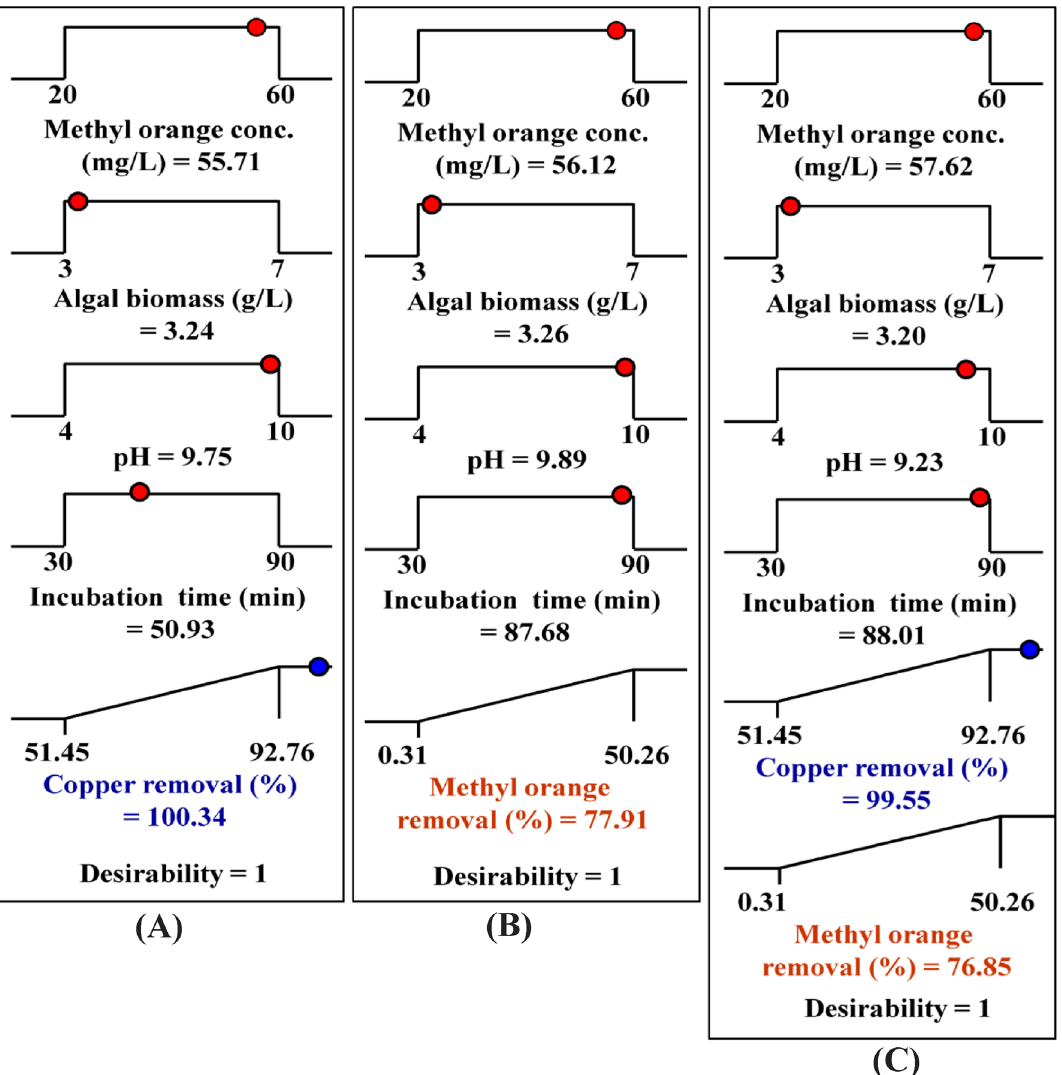
Figure 3. The optimization plot displays the optimum predicted values and the desirability function for maximum simultaneous removal percentages of anionic methyl orange azo dye as mono-component (A) ; cationic copper ions as mono-component (B) ; both copper ions and methyl orange in binary multi-component system (C) . This figure was created by using Design Expert version 7 for Windows FTIR analysis. The FTIR spectrums of brown alga F. vesiculosus biomass were analyzed before and after bio-adsorption of methyl orange and copper (Fig. 4) showing differences due to the interaction of methyl orange and copper ions with active sites (functional groups) that found in cell surface in biomass. The brown algae cell walls consist of cellulose, hemicelluloses, sulphated furans and also some unique polysaccharides (alginates) that have many active groups (hydroxyl, carboxylate, amino and phosphate groups) with negative charges that can interact with cationic dye and connect the ions of heavy metal 59 . The spectrum of FTIR analysis of brown alga F. vesiculosus before and after bio-sorption of MO and copper ions showed different absorption peaks at 3751, 3450, 2924, 2855, 1743, 1649, 1563, 1544, 1520, 1461, 1425,1397, 1342,1318, 1161,1063 and 672 cm −1 which has been shifted to 3450, 2962, 2925, 2855, 1742, 1647, 1564, 1545, 1520, 1461, 1426, 1399, 1342, 1270, 1160, 1066, 672 and 615 cm −1 . Figure 4 represent that very narrow peak at 3751 are present in the brown alga F. vesiculosus and no present after absorption MO and copper ions. Some other peaks are shifted in range 3 to –22 cm −1 due to the brown alga adsorbed copper ions and methyl orange. Also, the new peaks were observed at 1270 and 615 cm −1 this change may be due to bind of MO and copper on algal biomass. The narrow peak at 3751 cm −1 and broad peak at 3450 cm −1 are specified to the elongation of O–H group such as phenols, carboxylic acids, and alcohols 60 . Theivandran et al. 61 stated that peeks at 2924 cm −1 , 2962 cm −1 and 2855 cm −1 are related to C–H protraction vibration presence of alkenes. Peaks at 1743 and 1742 cm −1 are related to C=O stretching mode of lipids 62 . Peaks at 1649 cm −1 and 1647 cm −1 are correlated to N–H of adenine, thymine, guanine, cytosine 63 , peaks at 1544 cm −1 , 1545 at cm −1 and 1520 at cm −1 are correlated to amide II bands arises from C–N stretching 64–66 .